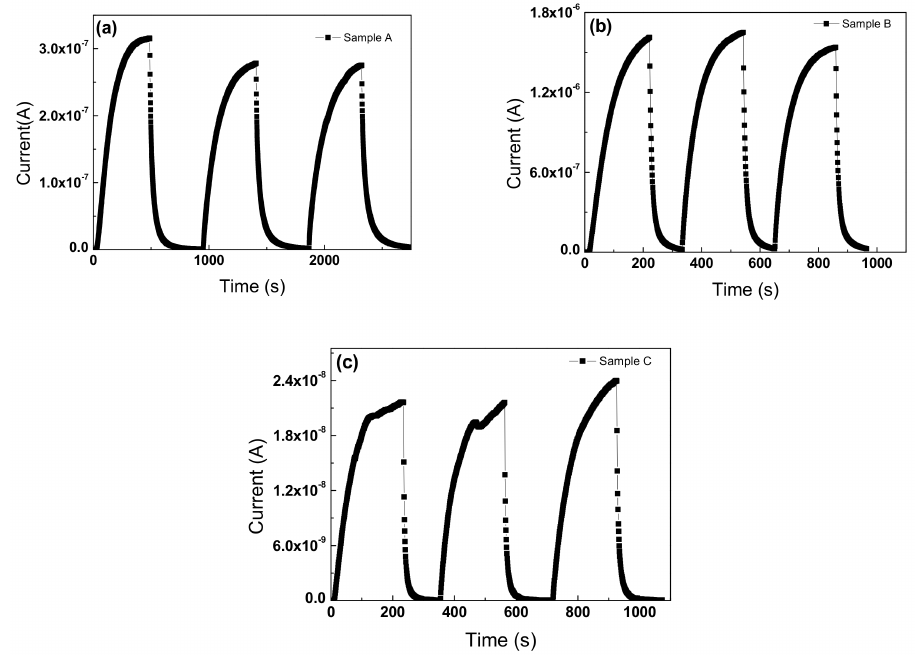
Figure 6. Time responses of ( a ) Sample A; ( b ) Sample B; and ( c ) Sample C.